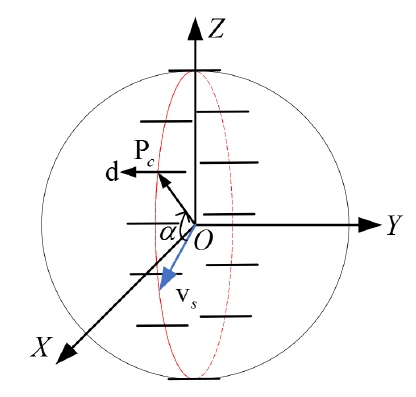
Figure 2. Specify a certain line by v s and α . The lines with fixed direction d and distance m l to the origin are all tangent of a circle(colored in red) with a radius of m l . A point P c on the circle corresponds to a certain